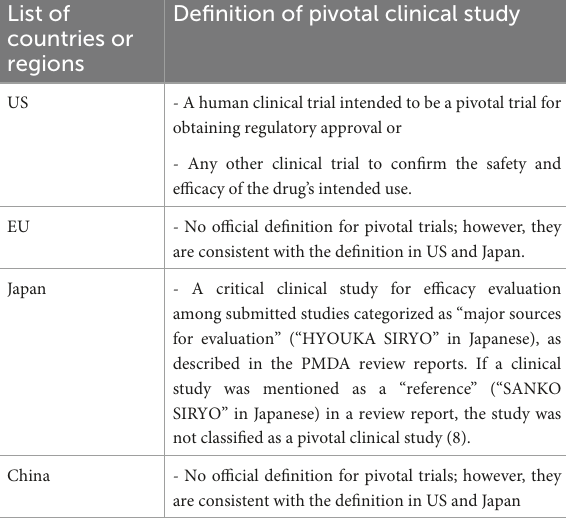
TABLE 3 Definition of a pivotal clinical